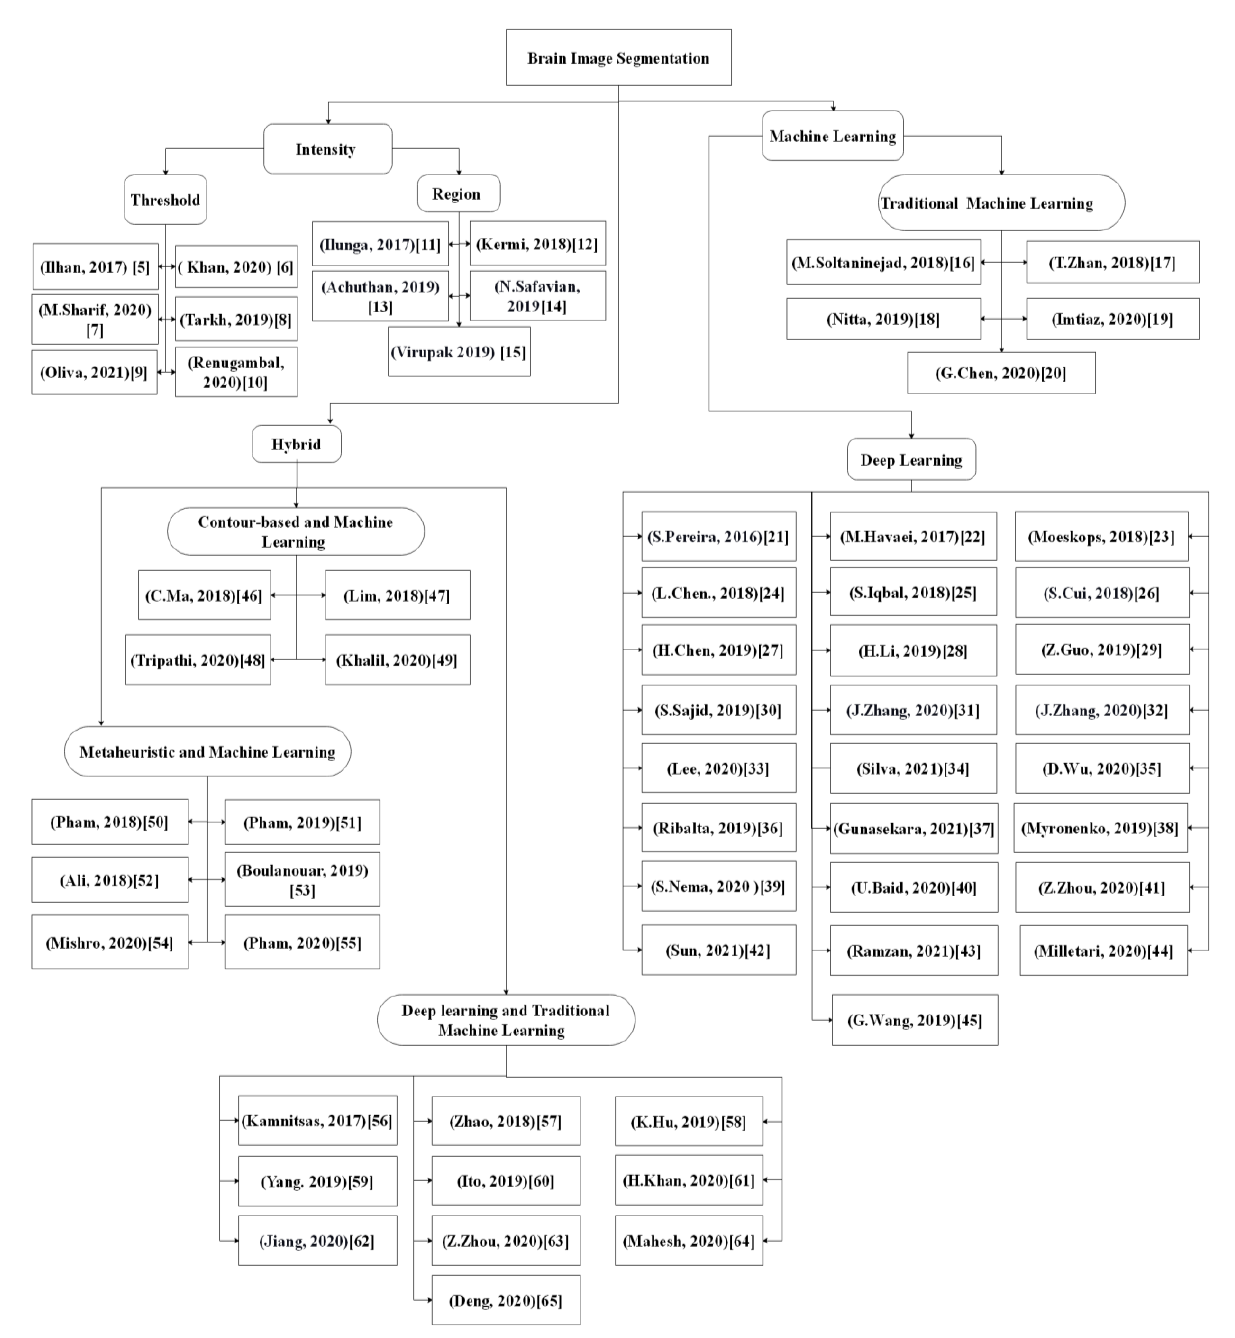
Figure 2. An overview of brain segmentation approaches [5 – 65].